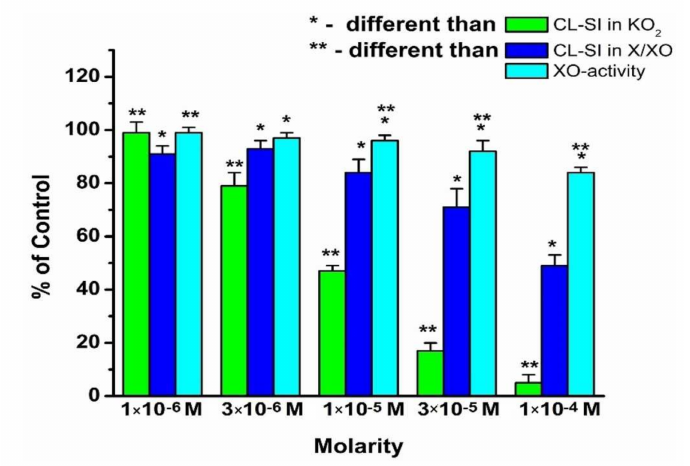
Figure 2. Radical-scavenging activity of HAOA toward superoxide radical formed in KO 2 and X/XO model systems, and activity of XO in the formation of uric acid (UA) in the X/XO model system. Data = mean ± StDev, p <